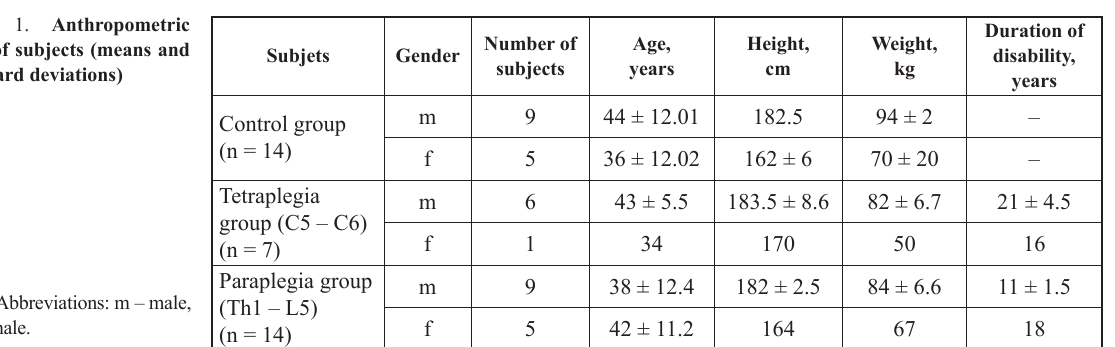
Note. Abbreviations: m – male, f –